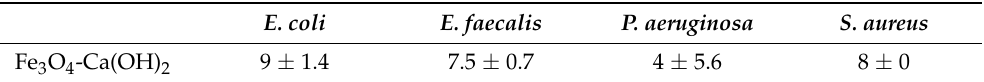
Table 3. Antibiogram results of dental magnetic composites material tested against bacterial strains using the diffusion method (mean ± standard deviation of two independent tests). The results are expressed in mm.